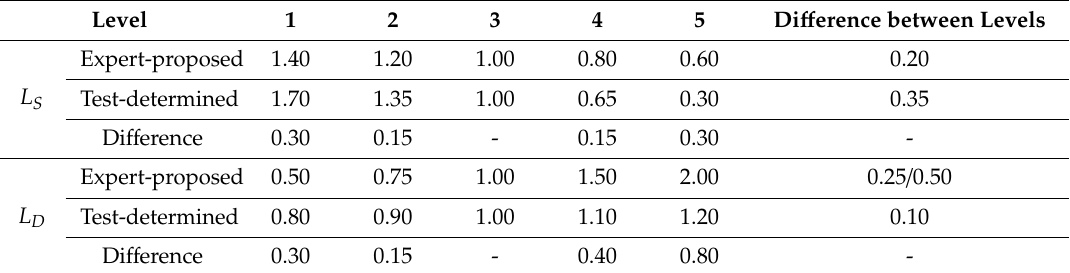
Figure 7. Correlation of L S and L D with working time and quality: ( a ) Relationship of L S and L D to working time; ( b ) relationship of L S and L D quality. Table 2. Comparison of L S and L D weight factors proposed by the experts with those determined from the test